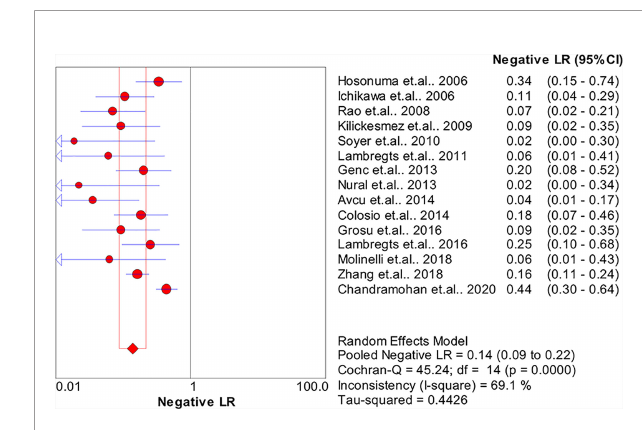
FIGURE 3 | Summary of the speci fi city analysis of the included studies.